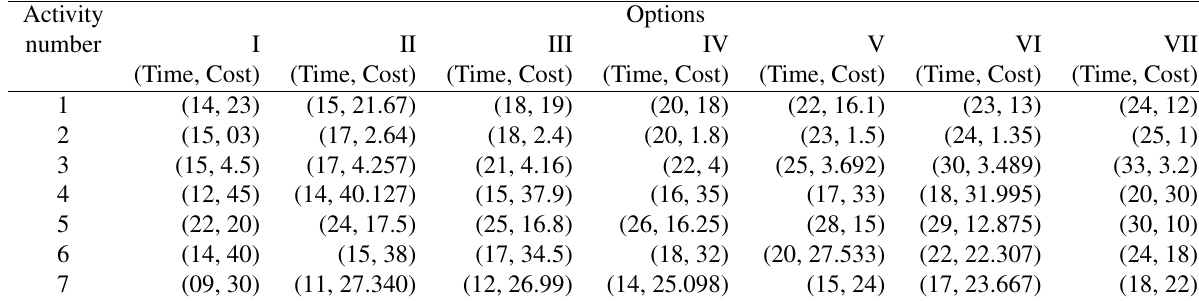
Table 1. Network data of first case study